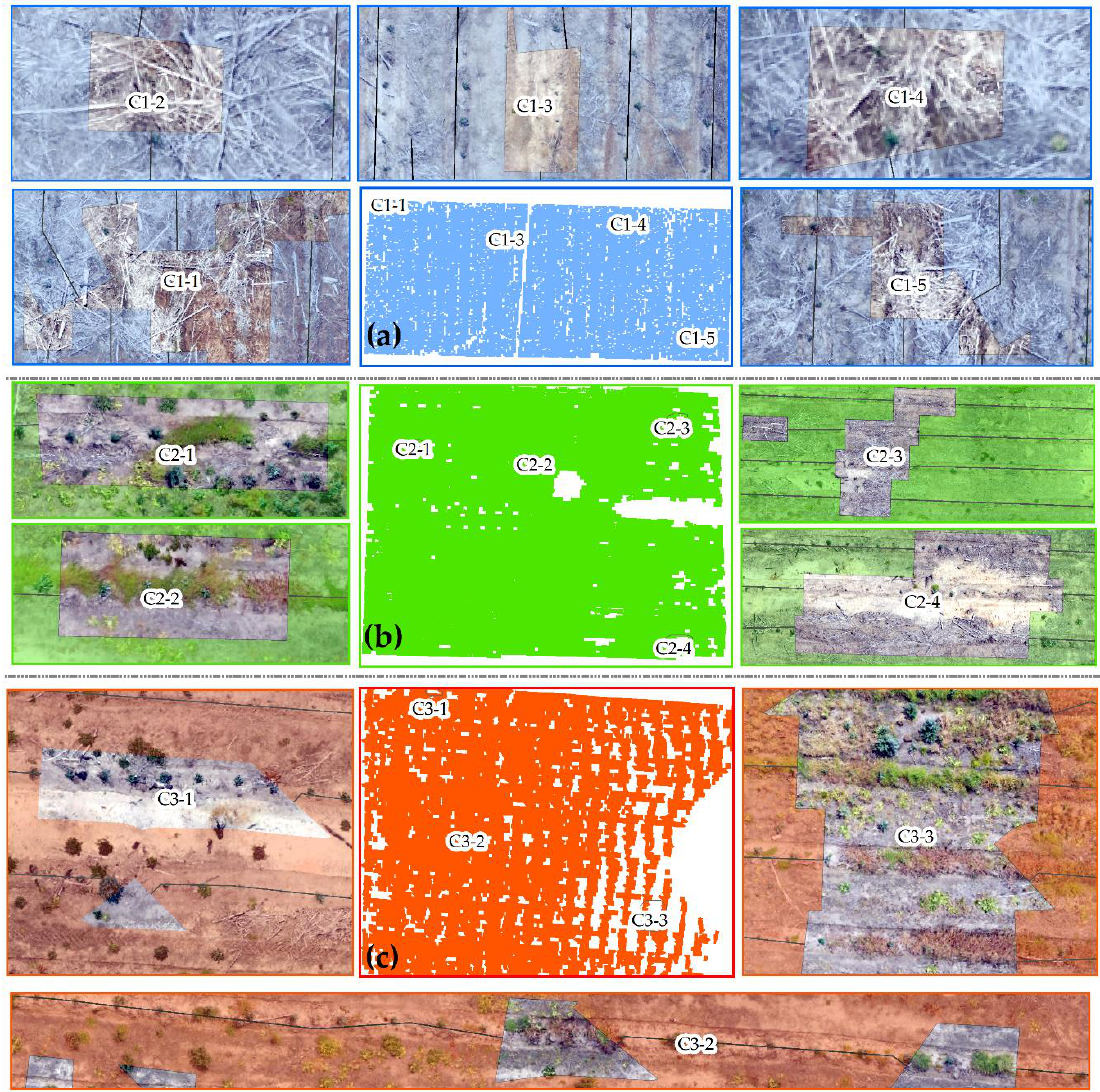
Figure 15. Plantation-row damage assessment for three compartments: ( a ) compartment-A, five sample locations (C1-1–C1-5) are shown; ( b ) compartment-B, sample locations (C2-1–C2-4) are shown; ( c ) compartment-C, sample locations (C3-1–C3-3) are shown.